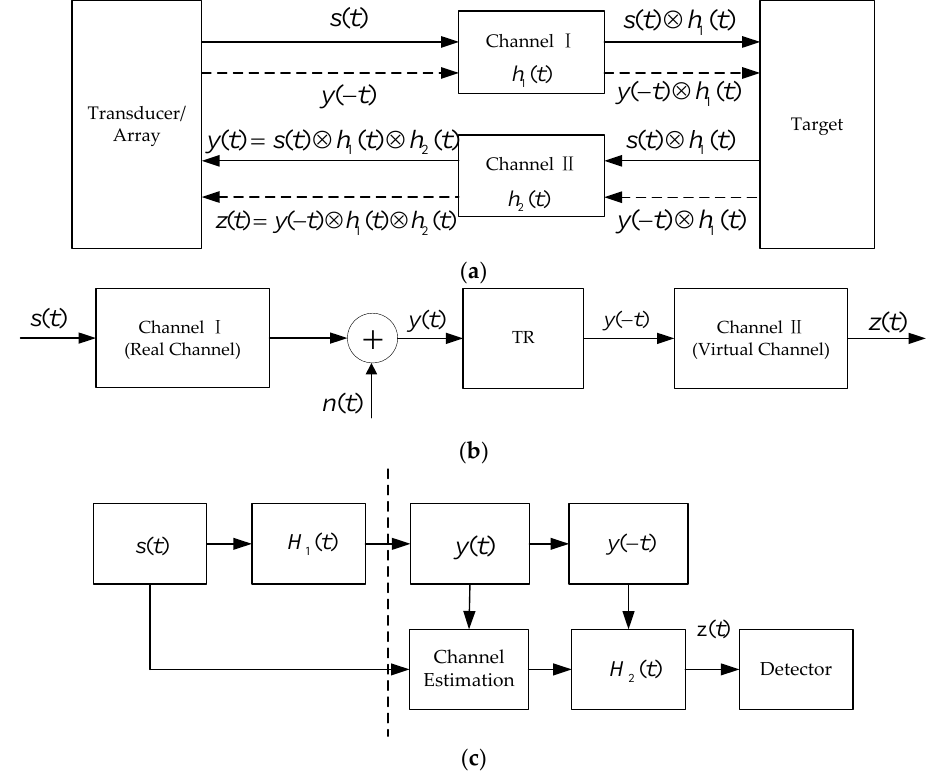
Figure 1. Diagram of ATR, PTR and ADVTR. ( a ) ATR; ( b ) PTR; ( c ) ADVTR.